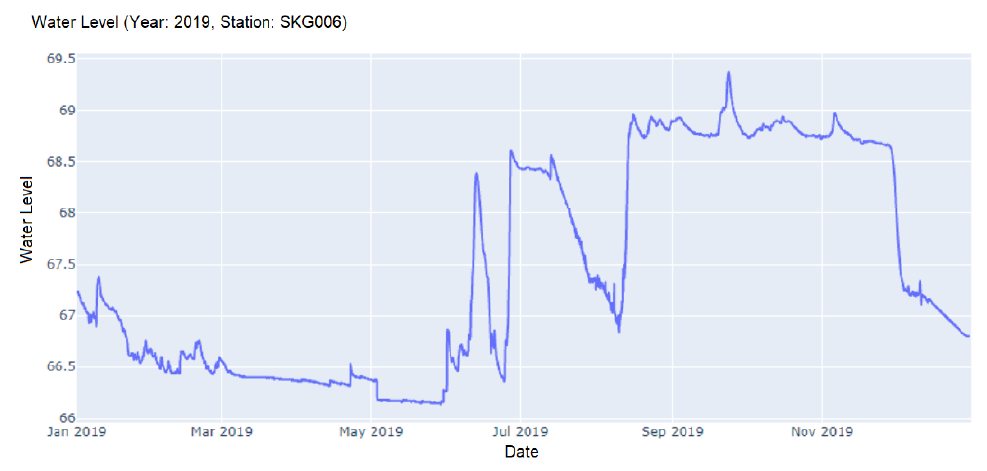
Figure 8. Station ‘SKG006’ in Cluster 4 which was incorrectly identified as Cluster 3.